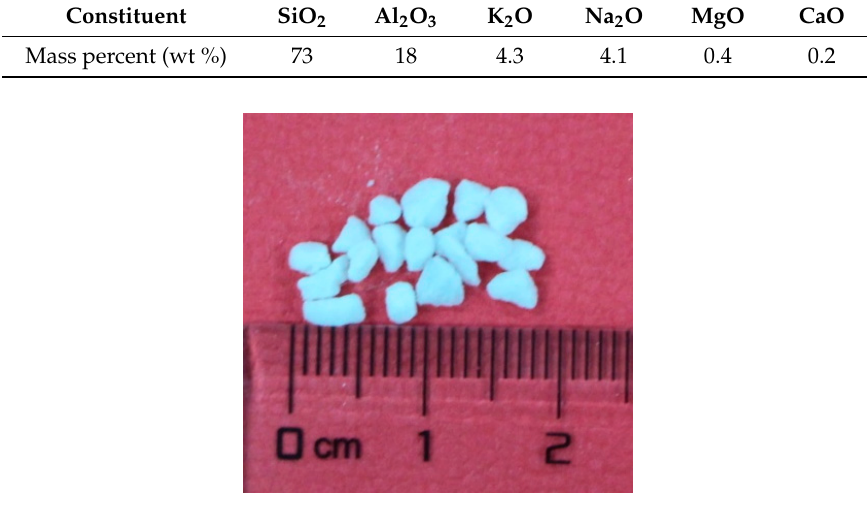
Figure 1. Appearance picture of EP.